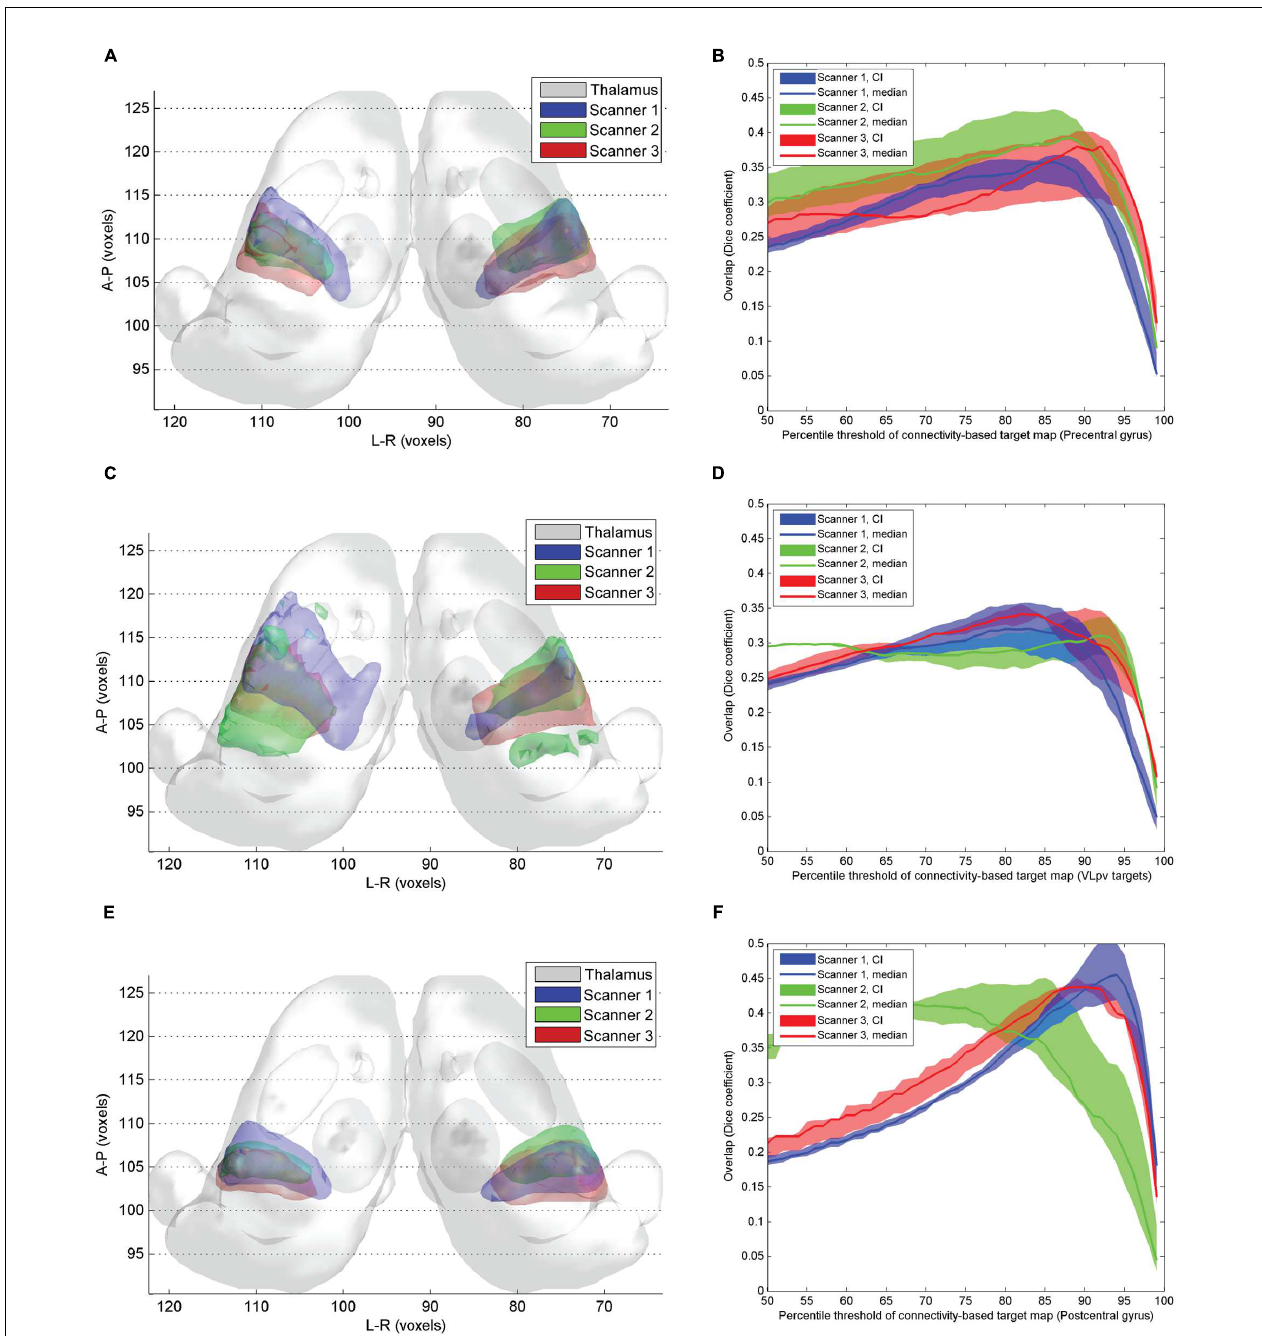
FIGURE 6 | Inter-scanner reproducibility of connectivity based intrathalamic targets. (A) 3D visualization of the inter-scanner variability of precentral CBT over the study population; (C) 3D visualization of the inter-scanner variability of VLpv CBT over the study population; (E) 3D visualization of the inter-scanner variability of VPLp CBT over the study population; (B) dependency of the inter-scanner variability of the precentral CBT volume on the applied connectivity threshold; (D) dependency of the inter-scanner variability of the VLpv CBT volume on the applied connectivity threshold; (F) dependency of the inter-scanner variability of the VPLp CBT volume on the applied connectivity